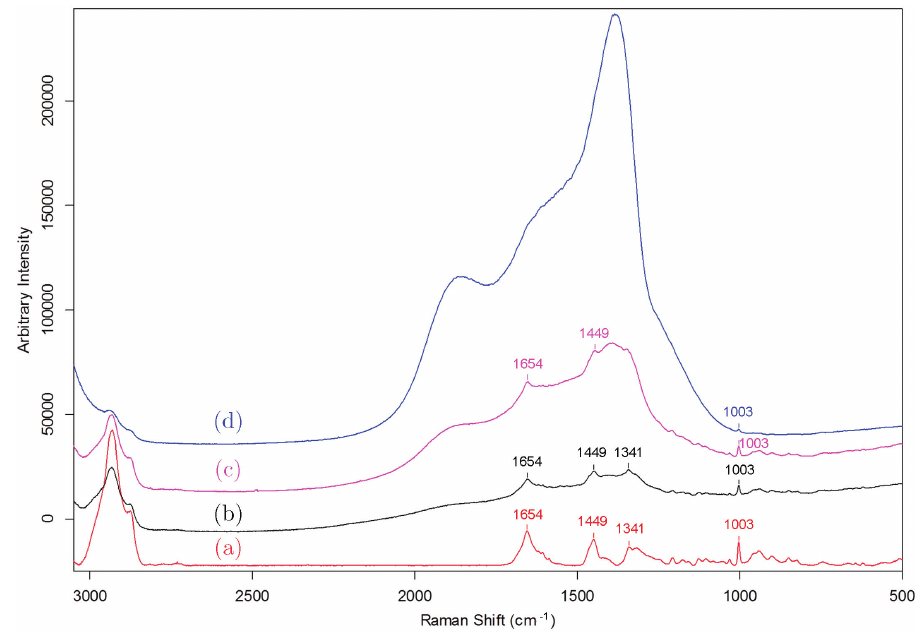
Fig. 1. The Raman spectra before extraction, where (a) is of the pure HSA water solution contained in quartz cuvettes, (b) is of the sample contained in ampoule, (c) is of the sample contained in vial and (d) is of the sample contained in big bottle with thick